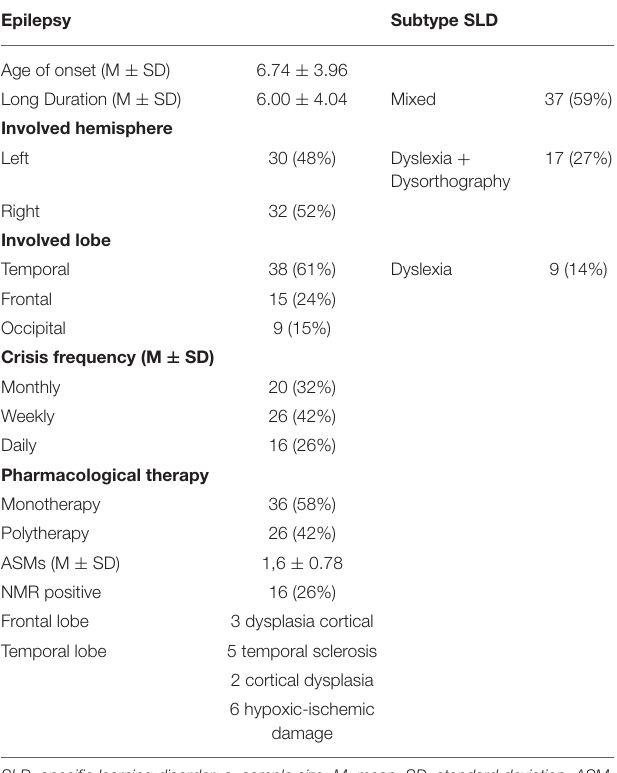
TABLE 2 | Epilepsy and specific learning disorder